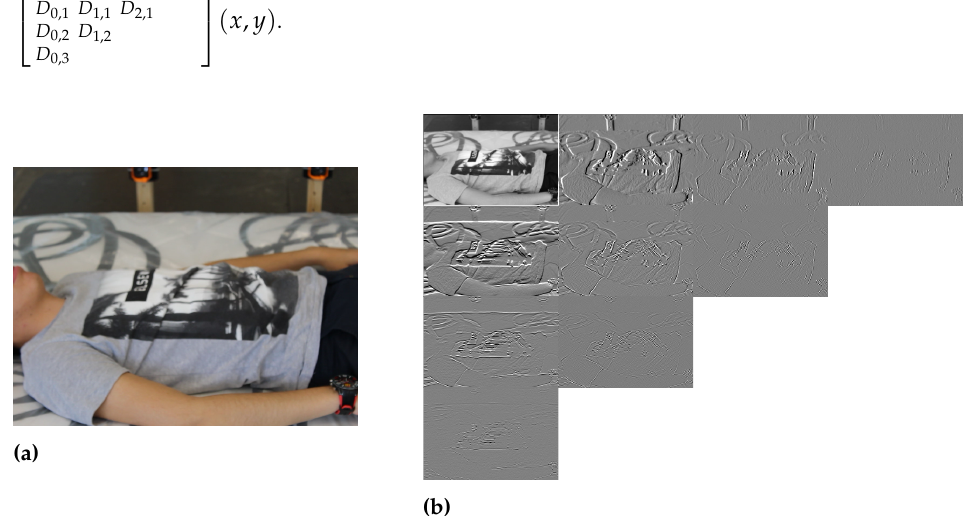
Figure 2. The Hermite filters D m , n − m ( x , y ) with N = 3 and their spatial distribution 